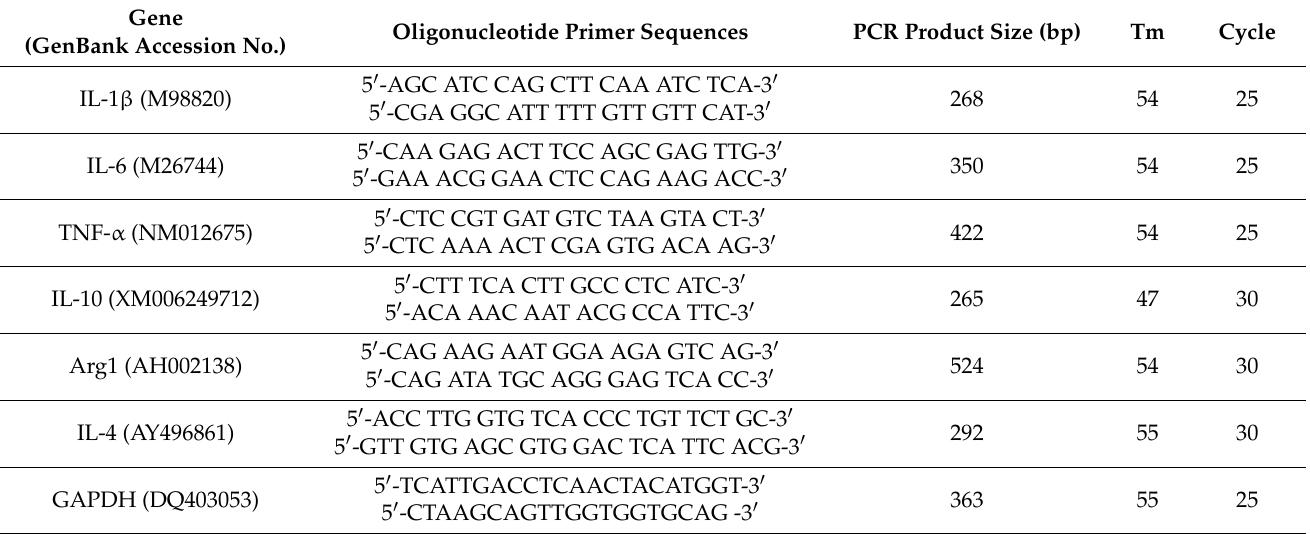
Table 2. Oligonucleotide primers used for the RT-PCR